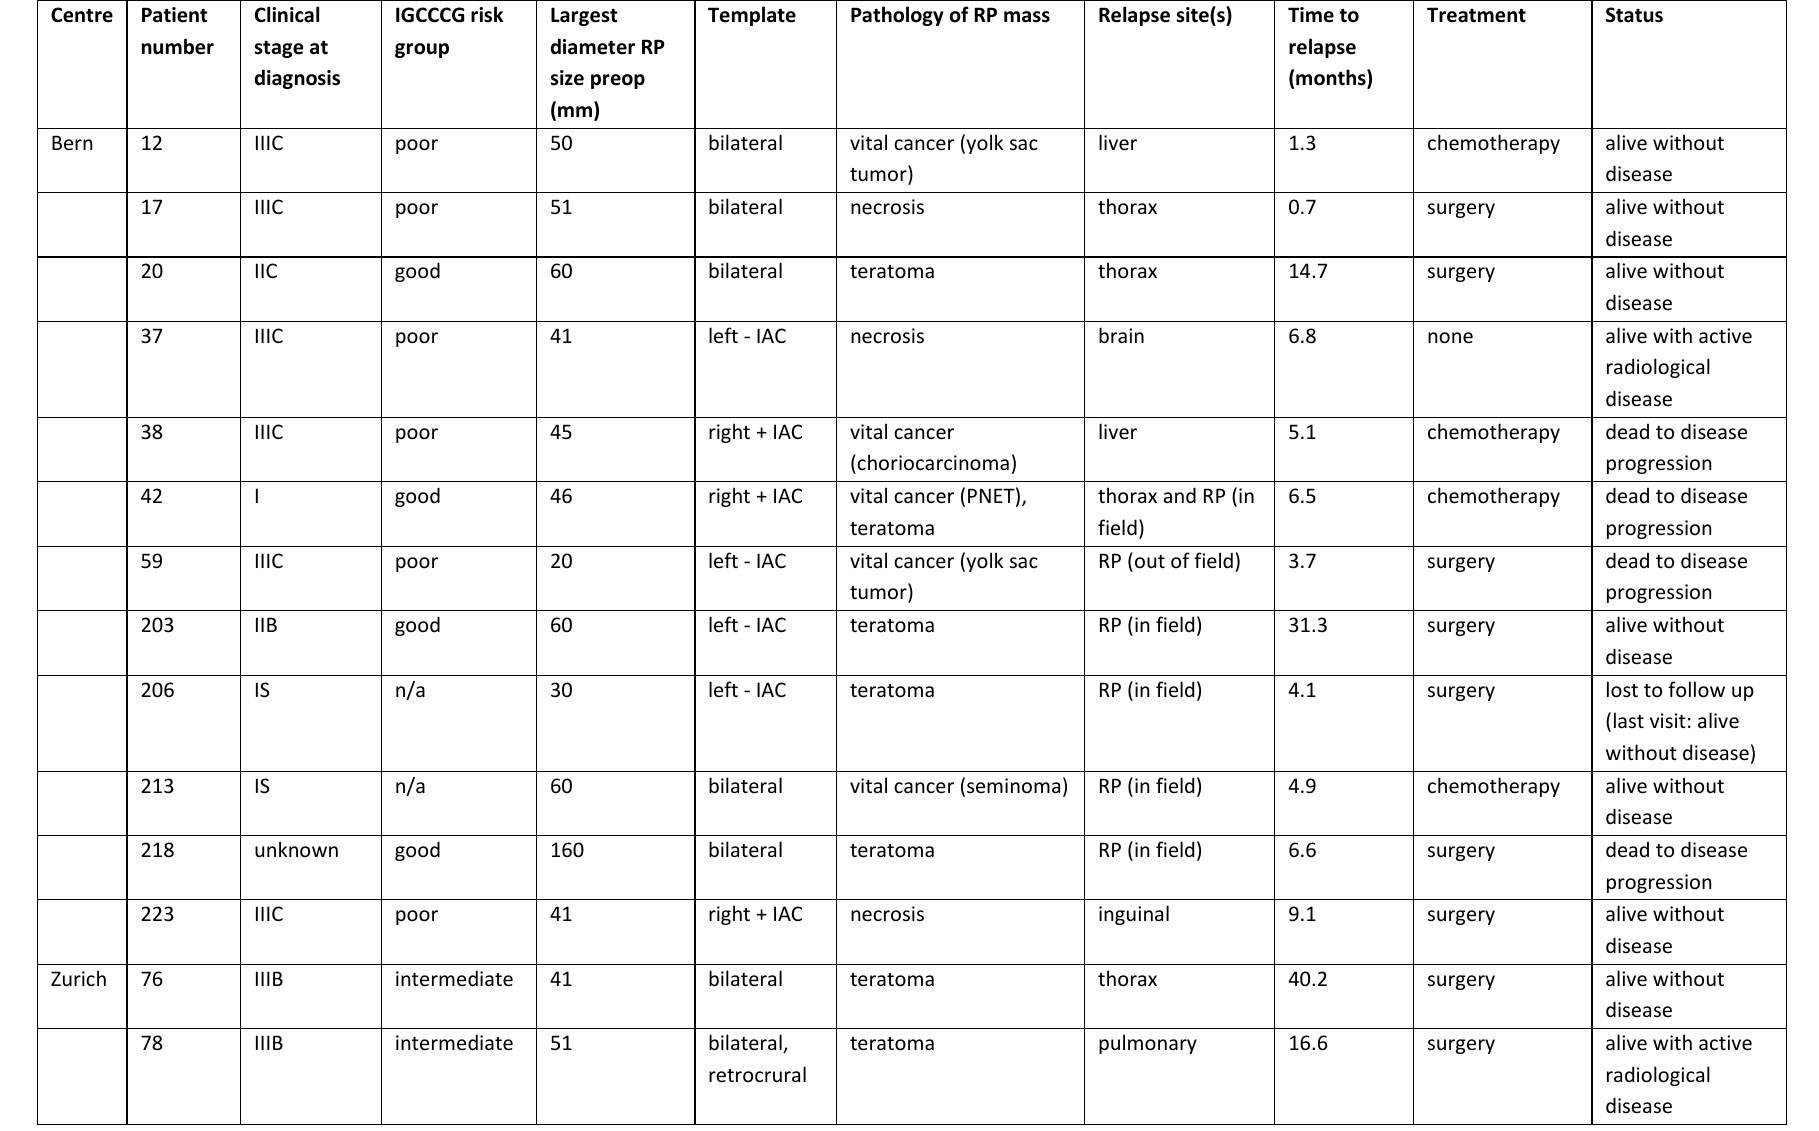
Supplementary table 8. Characteristics of patients with relapses after PC-RPLND.